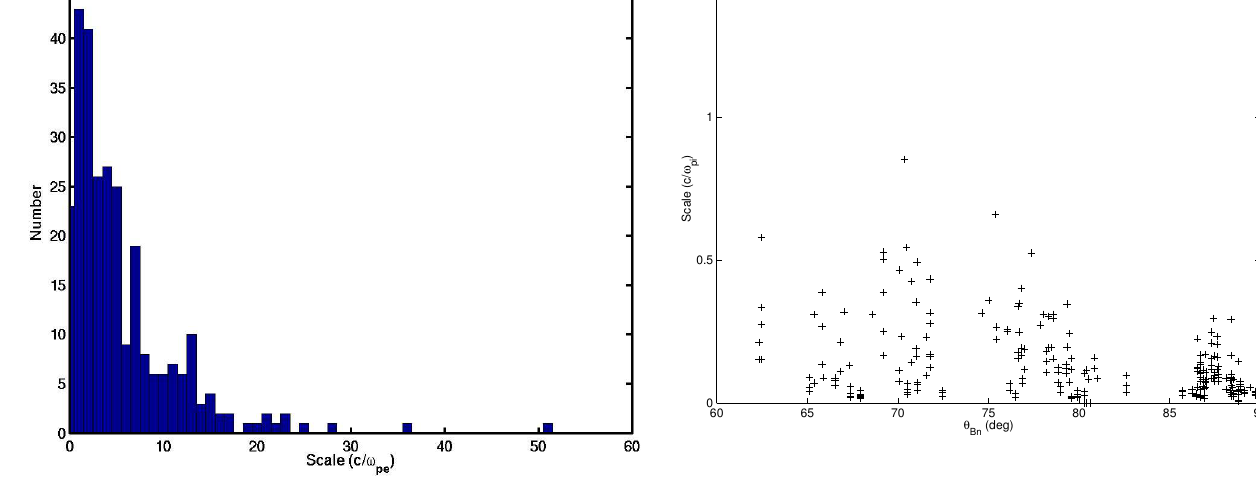
Fig. 10. Dependence of scale size on θ Bn .